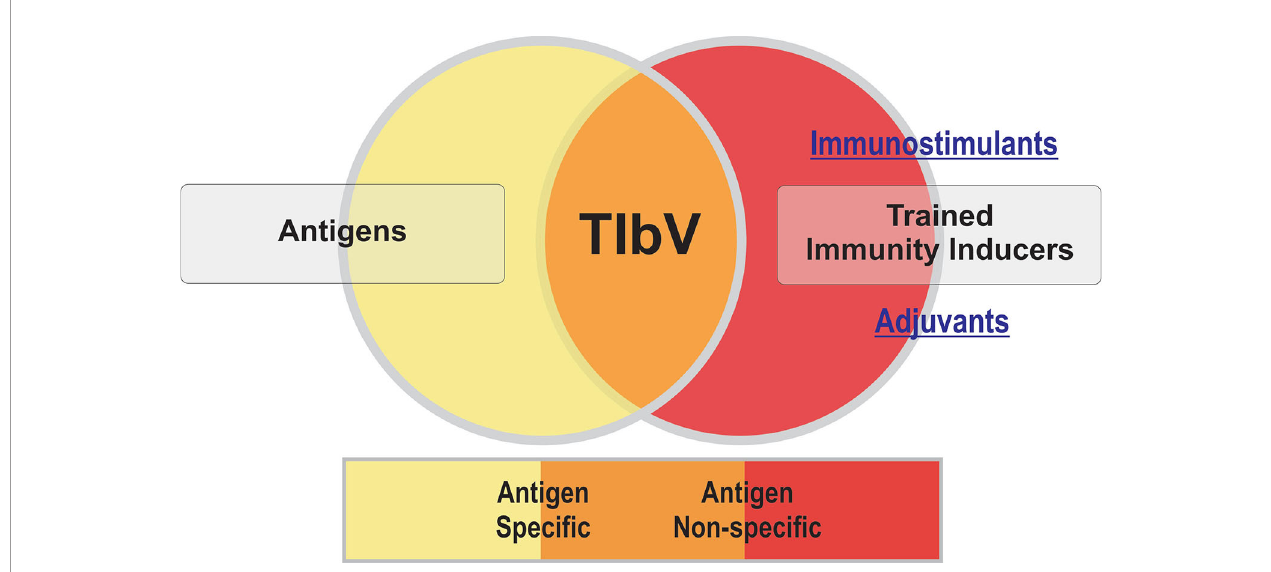
FIGURE 1 | Trained immunity-based vaccines (TIbV)